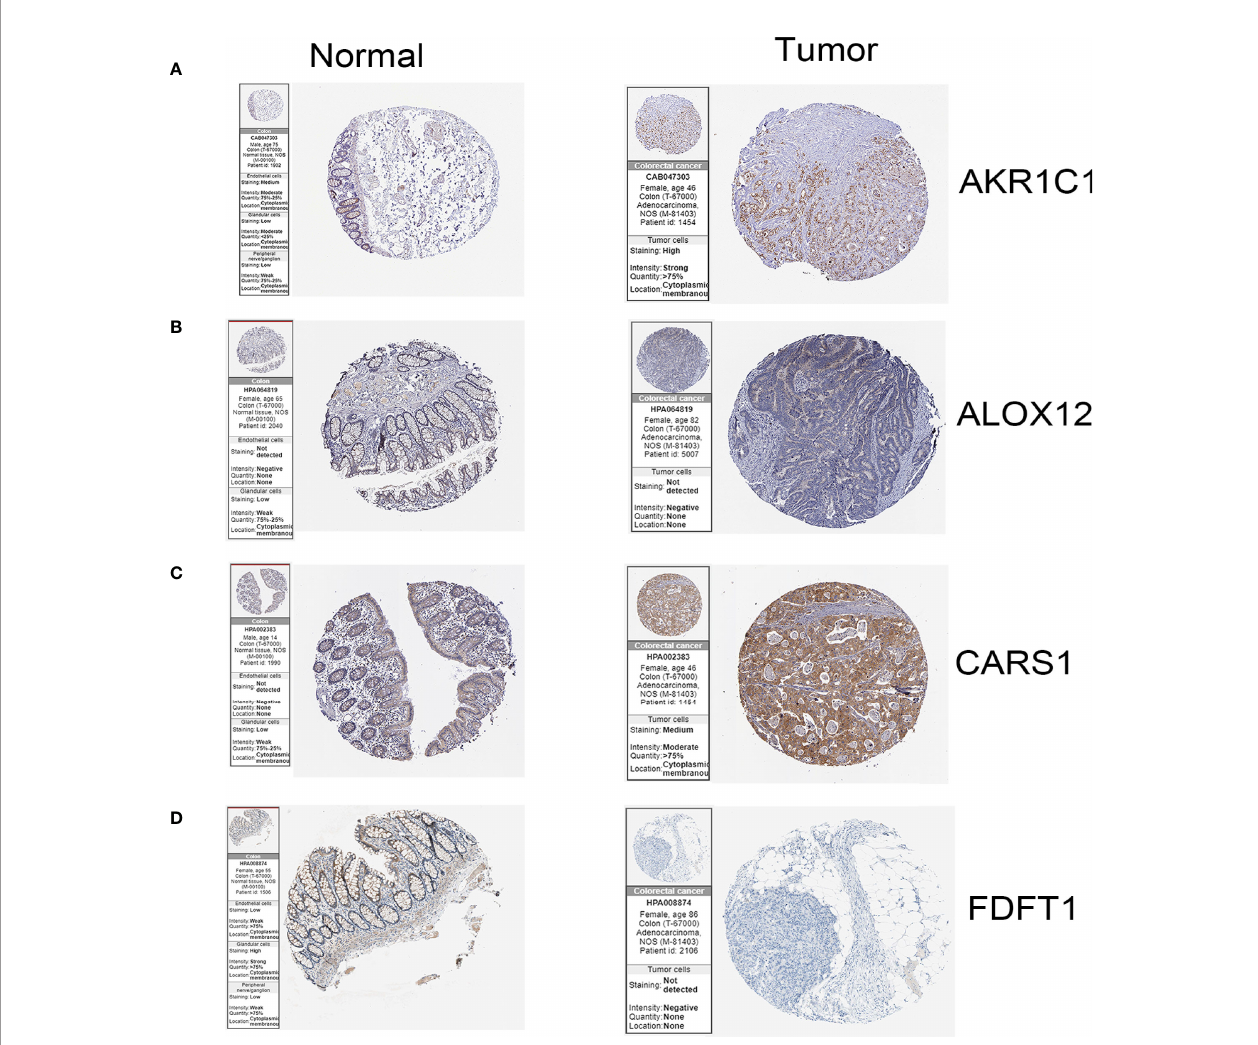
FIGURE 6 | The immunohistochemistry images of related genes from HPA database in normal and cancer tissues. (A) The expression levels of AKR1C1 in normal tissues and colon cancer tissue. (B) The expression levels of ALOX12 in normal tissues and colon cancer tissue. (C) The expression levels of CARS1 in normal tissues and colon cancer tissue. (D) The expression levels of FDFT1 in normal tissues and colon cancer